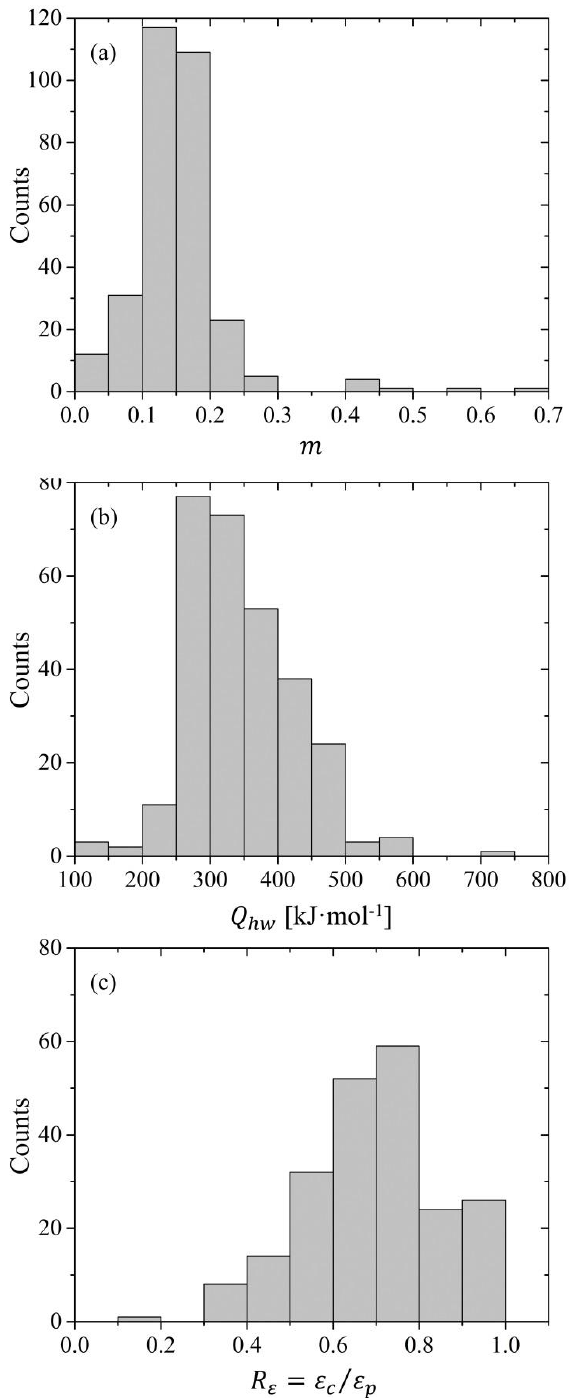
Figure 8. Statistical analysis of the reviewed data: ( a ) m , ( b ) Q hw , and ( c ) R ε .